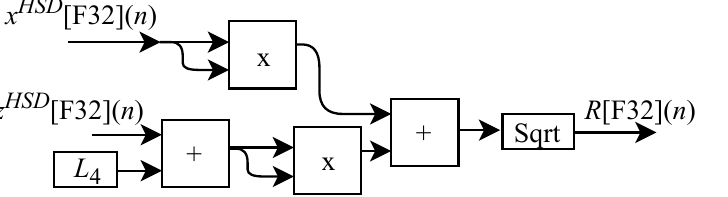
Figure 12. Proposed circuit to perform the calculation of R [ F 32 ]( n ) (Equation (19))—IK-HSD.